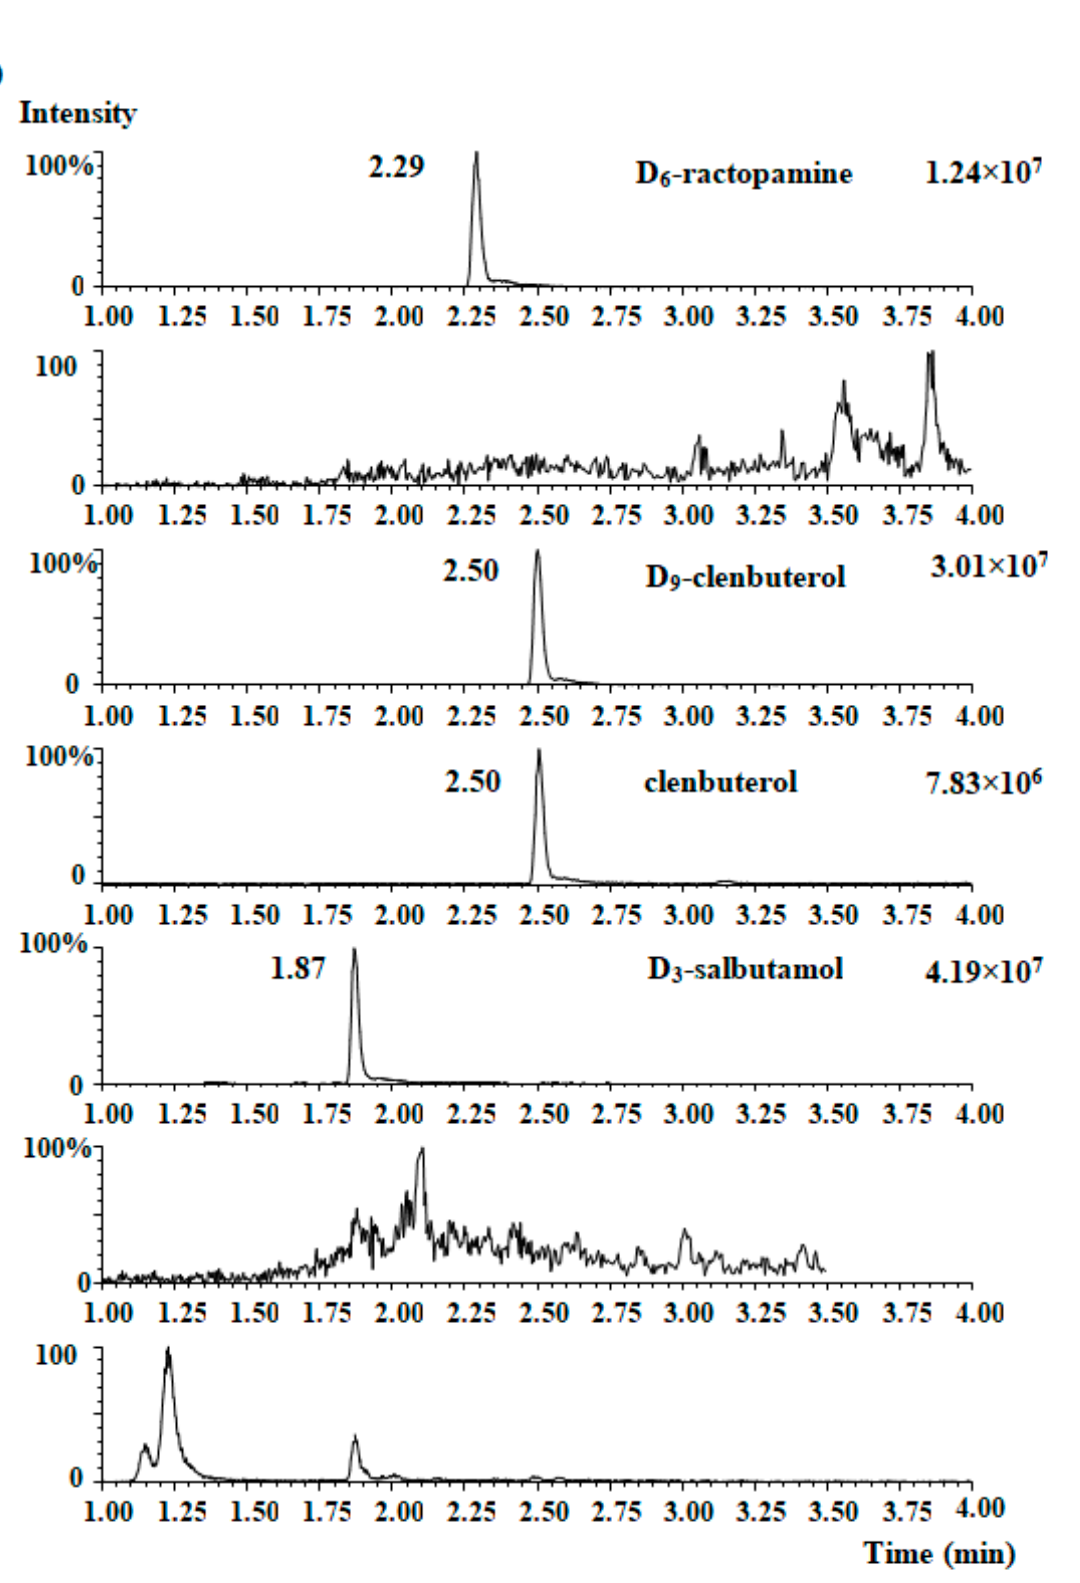
Figure 2. MRM chromatographs of four β 2 -agonists in the blank ham sample ( a ), the blank spiked ham sample ( b ), and the presence of clenbuterol (15.2 µ g/kg) in one ham sample ( c ).